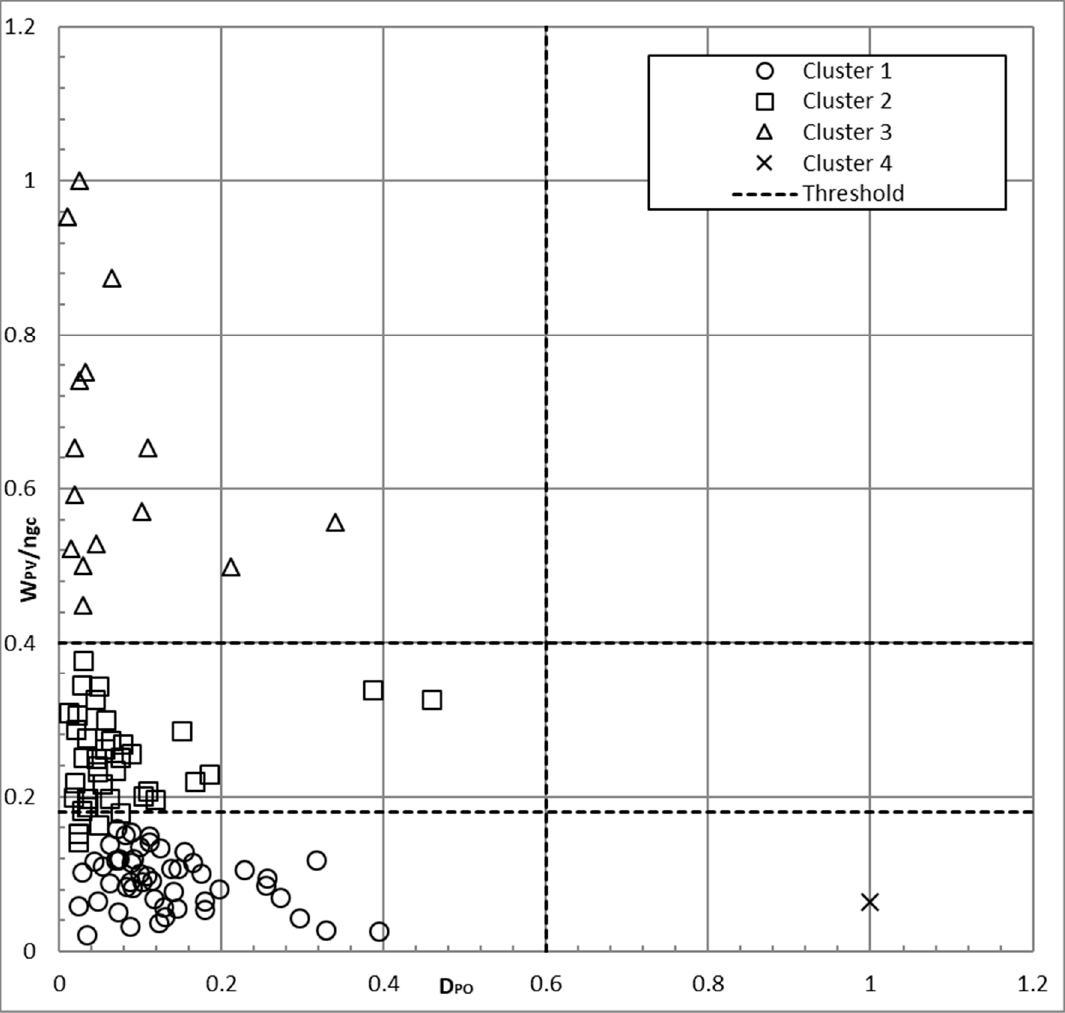
Figure 6. Clustering obtained by means of k-means algorithm applying the attributes (cid:2907) (cid:3148)(cid:3154)